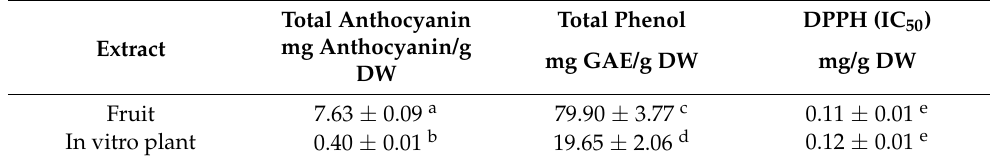
Table 1. Content of total anthocyanins, total phenols, DPPH (IC 50 ) of aqueous extracts of fruit and in vitro plant of A. chilensis . Mean ± standard deviation. Significant differences are denoted by different letters, ( p < 0.05).